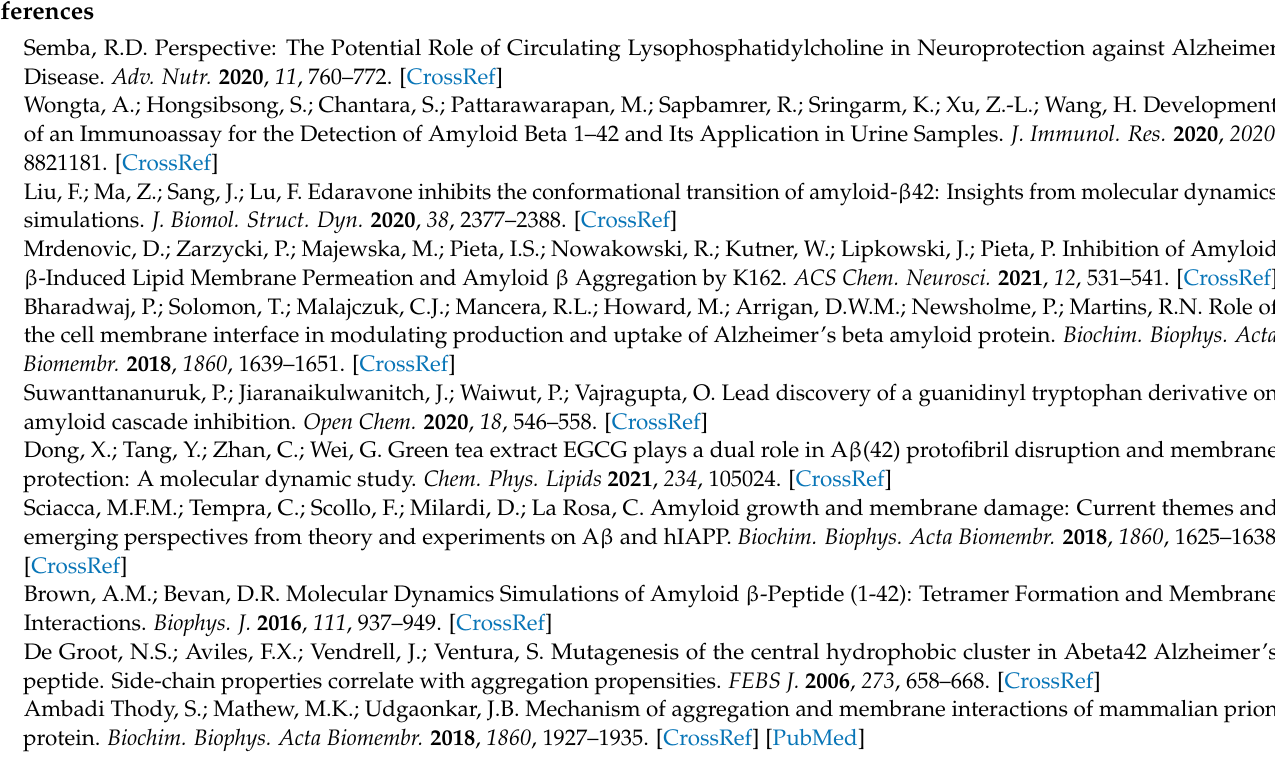
Figure S3. The mobilities in the z-direction of the A β 1-42 monomer structures in (A) TGN1, (B) TGN2, (C) TGN3, (D) TGN4, and (E) no ligand (only monomer) models in the POPC membranes are shown as MSD on the ps